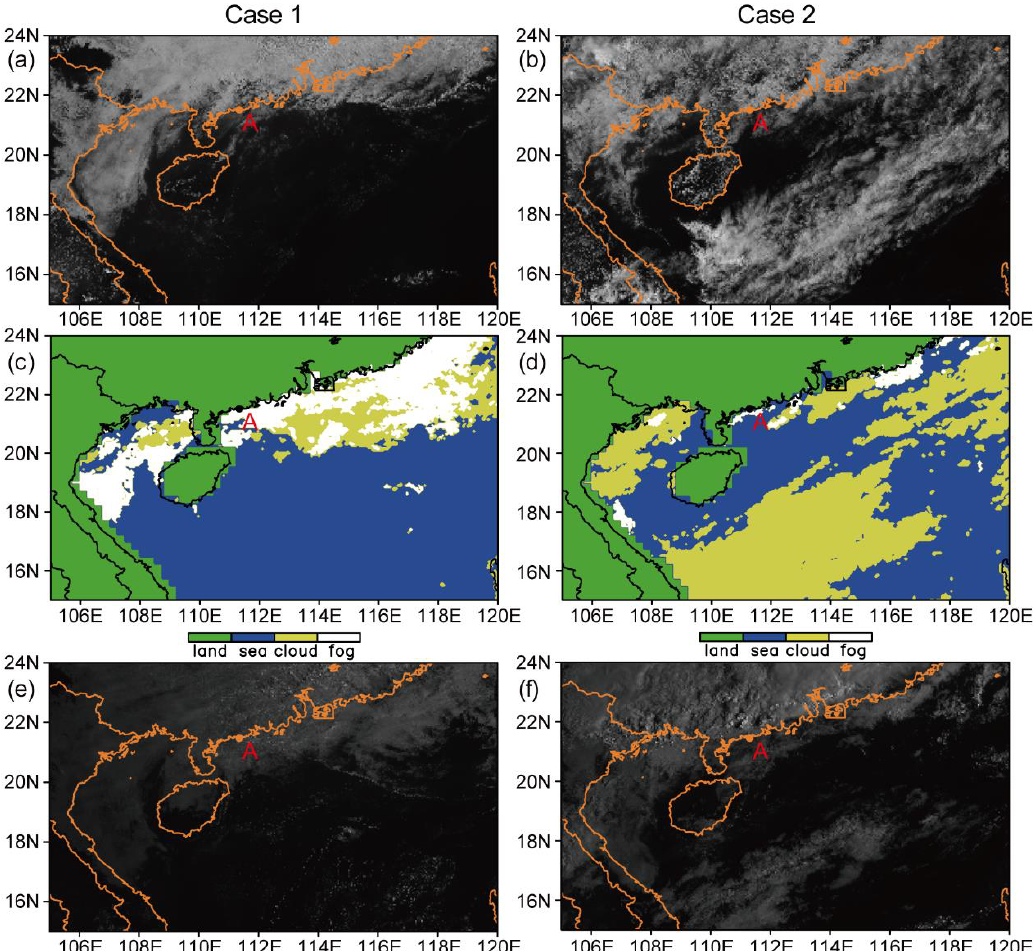
Figure 3. Visible cloud image from Himawari-8 and retrieval of the fog-cloud based on the Himawari-8 data of case 1 (left column) and case 2 (right column). ( a ) 1600 LST 10. ( b ) 1600 LST 30 March. ( c ) 0200 LST 11 March. ( d ) 0200 LST 31 March. ( e ) 0900 LST 11 March. ( f ) 0900 LST 31 March (A is the coastal site.).